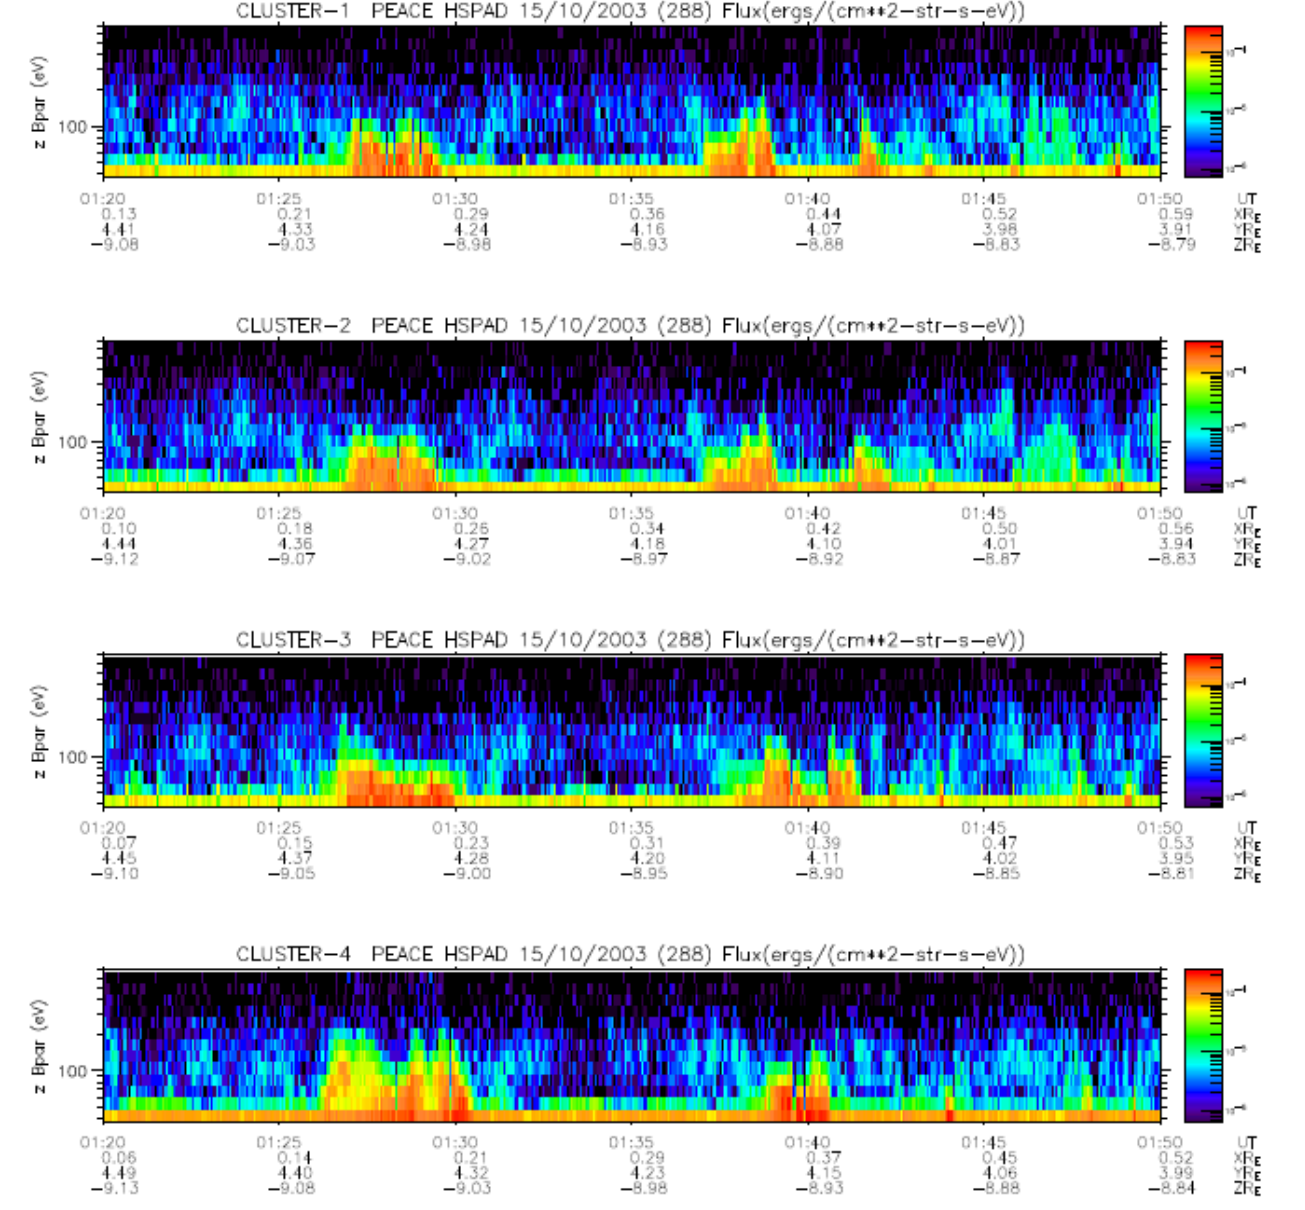
Fig. 3. Electron energy flux spectrograms in the upward direction along the magnetic field lines on 15 October 2003 between 01:20 and 01:50 UT, for the 4